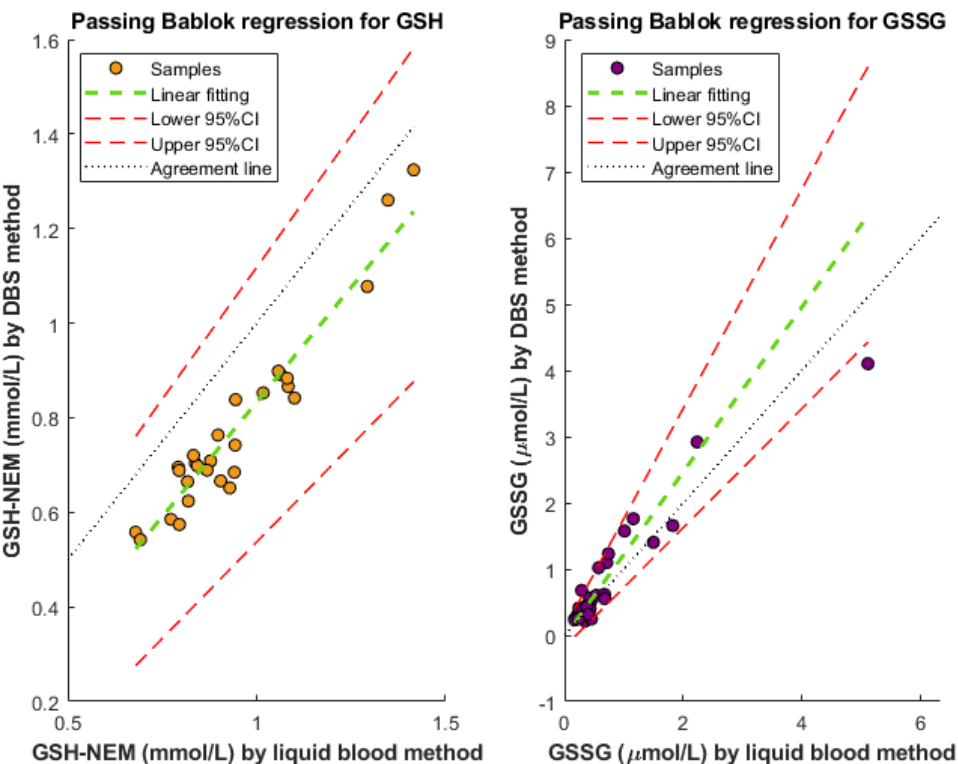
Figure 3. Passing–Bablok regression for GSH-NEM ( left ) and GSSG ( right ) for the comparison between the proposed DBS method and a previously developed method for liquid blood samples.